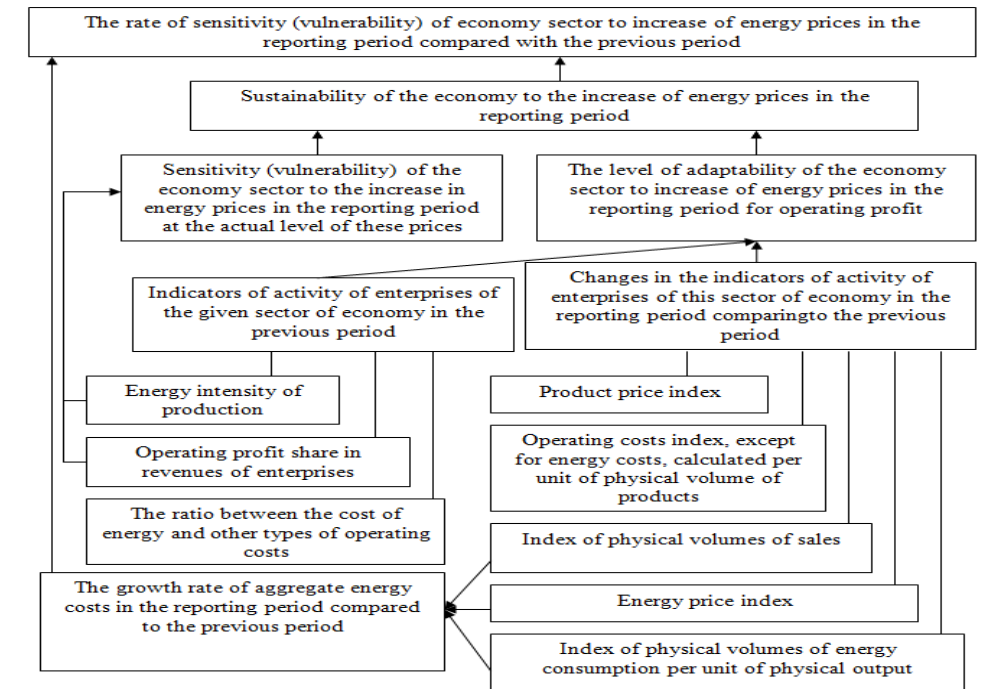
Figure 3. Model of the relationship between the sustainability, sensitivity and adaptability of the economy to the increase in energy prices. economy to the increase in energy